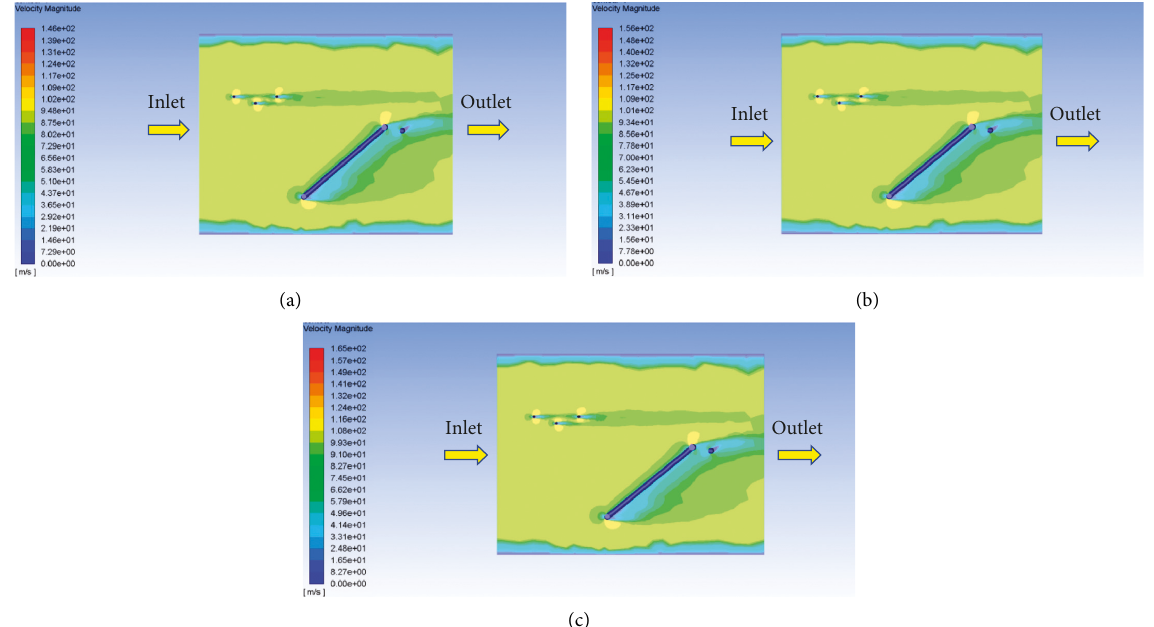
Figure 9: Instantaneous computational velocity contours for train speeds of (a) 300km/h, (b) 320km/h, and (c) 340 km/h around the pantograph in the symmetry plane.